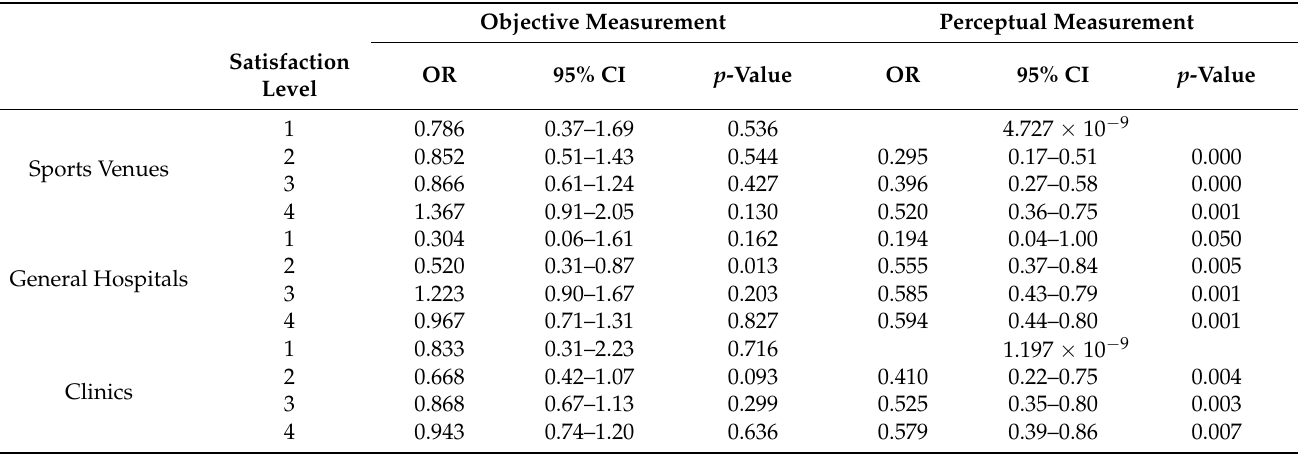
Table 9. Disordered logistic regression analysis of objective and perceptual measurements of accessi- bility of and accessibility satisfaction with health service facilities.